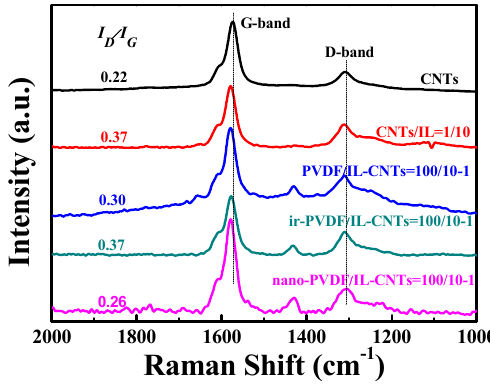
Figure 10. Raman spectra of pristine CNTs, IL coated CNTs (CNTs/IL = 1/10), PVDF/IL-CNTs (100/10-1), as-irradiated PVDF/IL-CNTs (100/10-1) and nano-PVDF/IL-CNTs (100/10-1) samples, respectively.